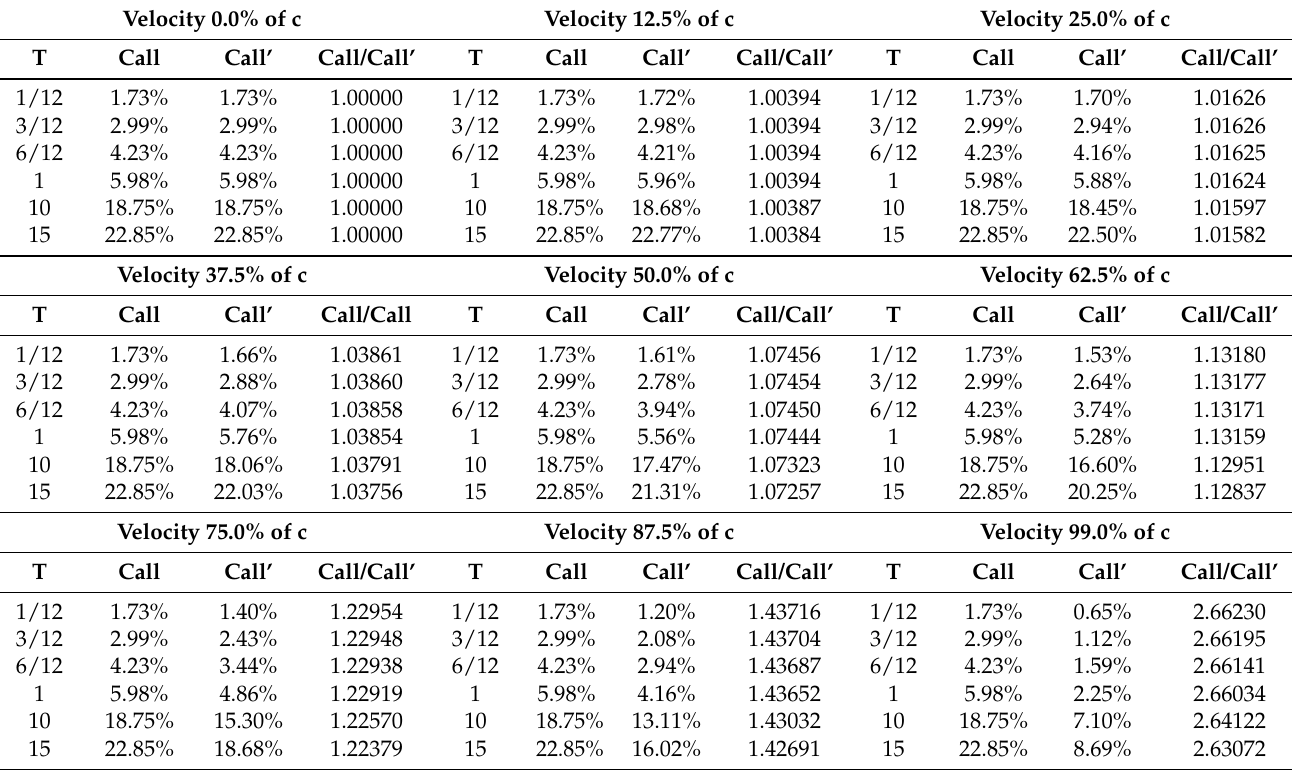
Table 1. Prices of Call , Call (cid:48) as well as the Call / Call (cid:48) ratio, for the maturities 1/12, 3/12, 6/12, 1, 10 and 15 years and for the velocities 0.0%, 12.5%, 25.0%, 37.5%, 50.0%, 62.5%, 75.0%, 87.5% and 99.0% of c . The asset volatility is fixed at σ = 15%. For simplicity, we consider values at inception t = 0 and r = 0% and both asset prices at inception and strike equal to one S = K =